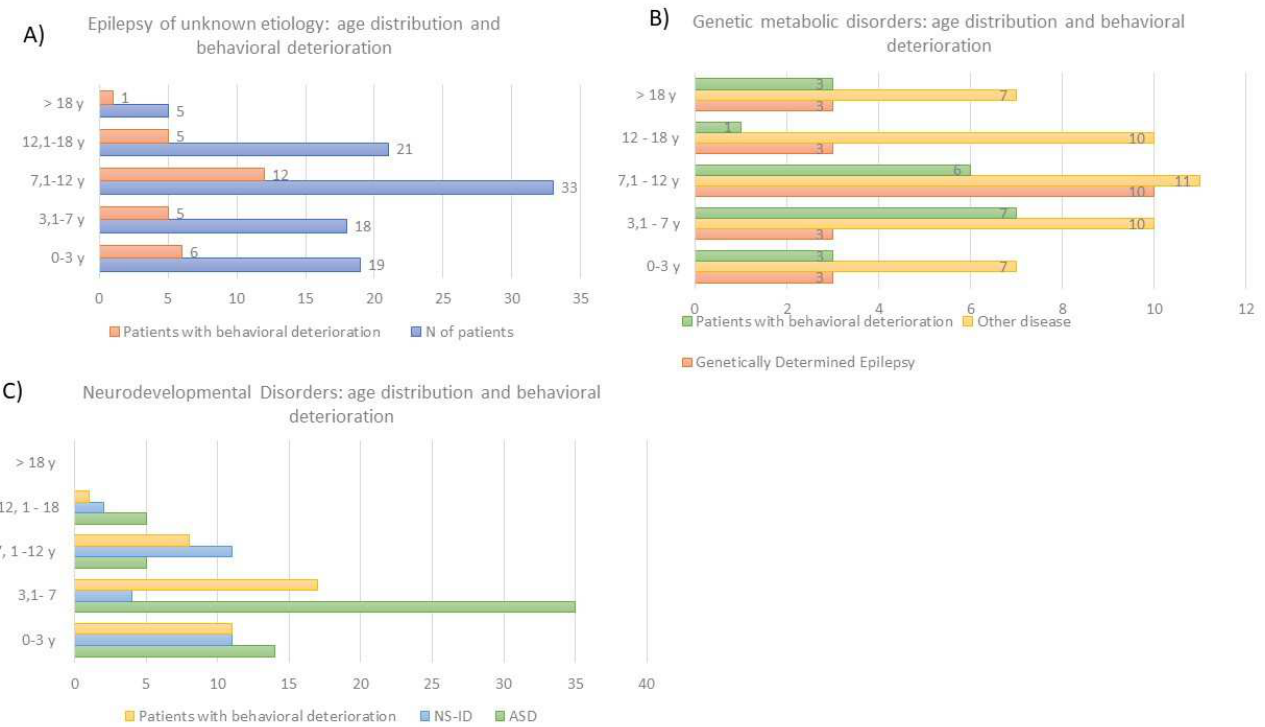
Figure 1. The age distribution among the three groups of diagnosis that were analyzed in this study: ( A ) Patients with epilepsy of unknown etiology; ( B ) Patients with genetic-metabolic diseases (including patients with genetically determined epilepsy); ( C ) Patients with neurodevelopmental disorders (including patients with autism spectrum disorder, patients with developmental delay, and patients with non-syndromic intellectual disability). For each group, the distribution of patients with behavioral deterioration is also reported. LEGEND: y = years; ASD = autism spectrum disorder; NS-ID = non syndromic intellectual disability.